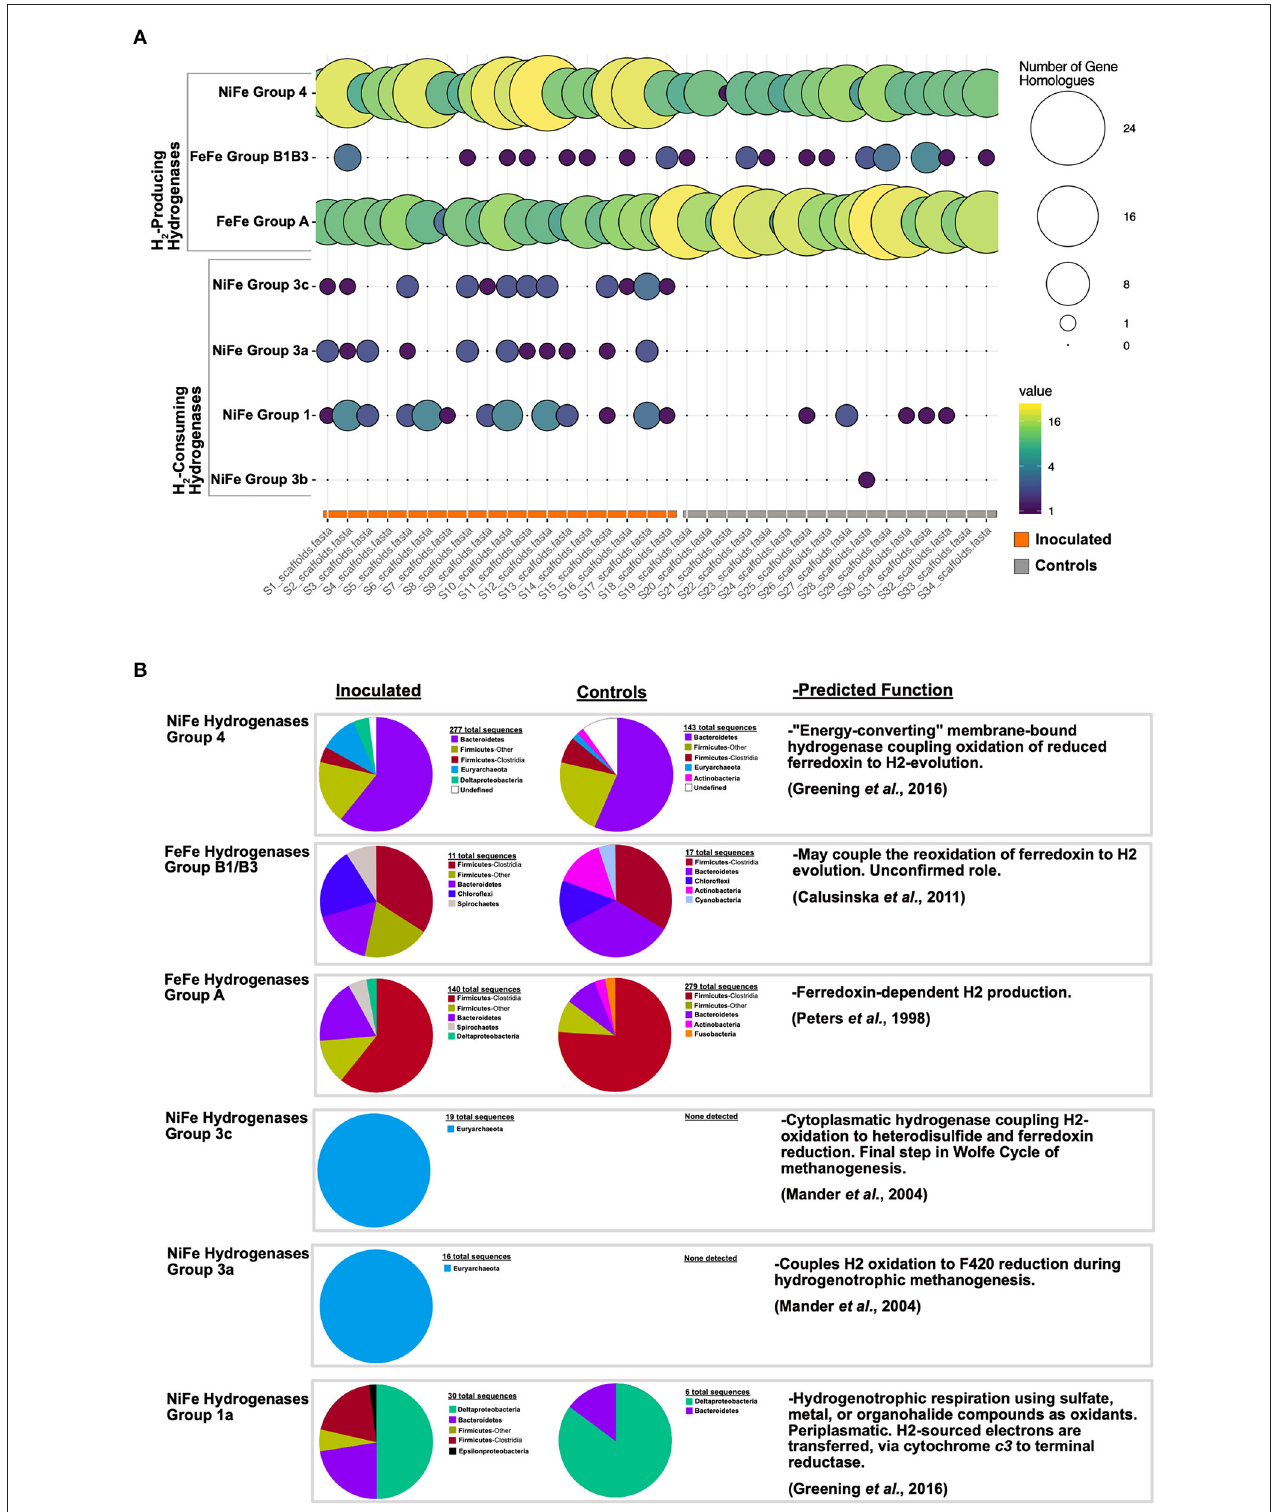
FIGURE 5 | Hydrogenase gene survey. (A) pHMM-based hydrogenase survey of all cecal metagenomes. Circle size and color reflect the number of detected gene homologs per hydrogenase category. (B) Phylogenetic assignment and predicted function for hydrogenase gene homolog categories from FMT inoculated and control cecal